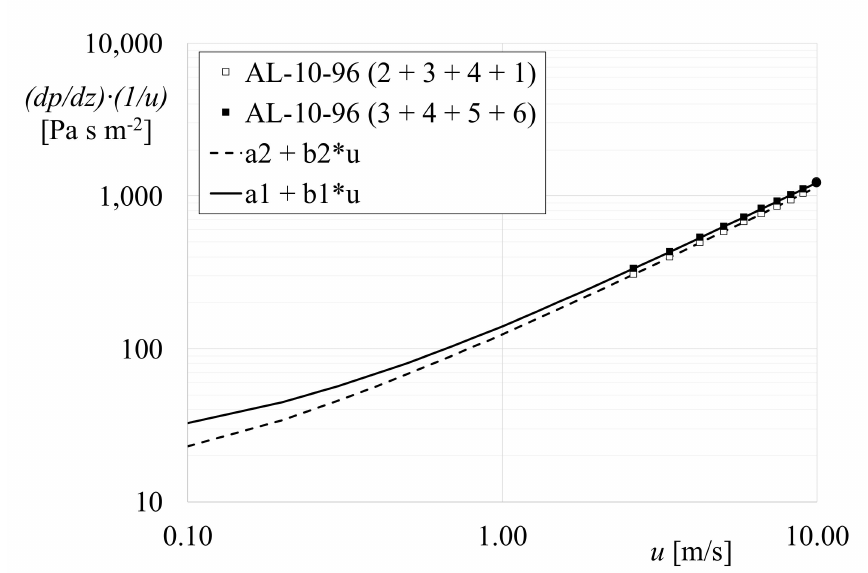
Figure 4. Pressure gradient (absolute value) scaled on the air velocity as a function of the frontal air velocity for two series of experimental data obtained for two assemblies with four samples ( H = 80